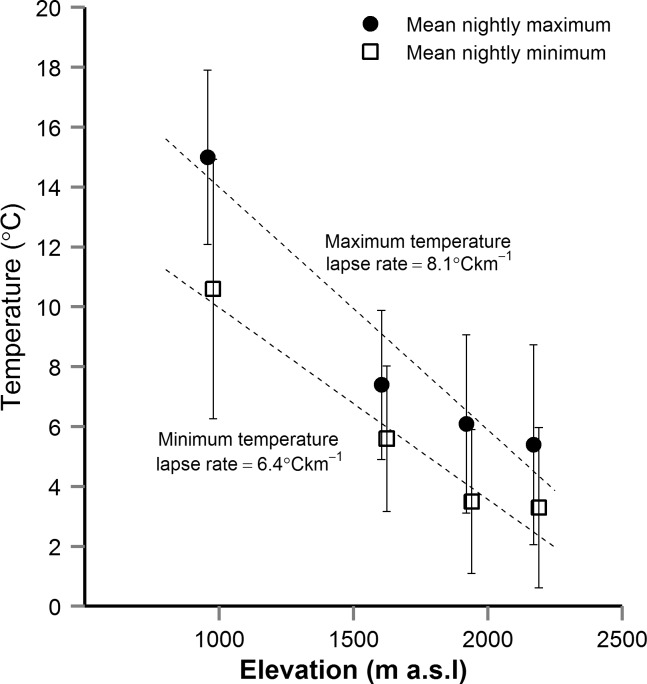
Microclimate temperature variation on Mt. Rainier.Mean (± s.d.) temperature variation among four Nebria collection sites on Mt. Rainier. Temperatures were recorded every 30 minutes for 44 days from June 20th to August 2nd, 2014, with DS1922L iButtons. Mean nightly maximum (filled circles) and minimum (open squares) were calculated for each site using temperatures between the hours of sunset and sunrise.